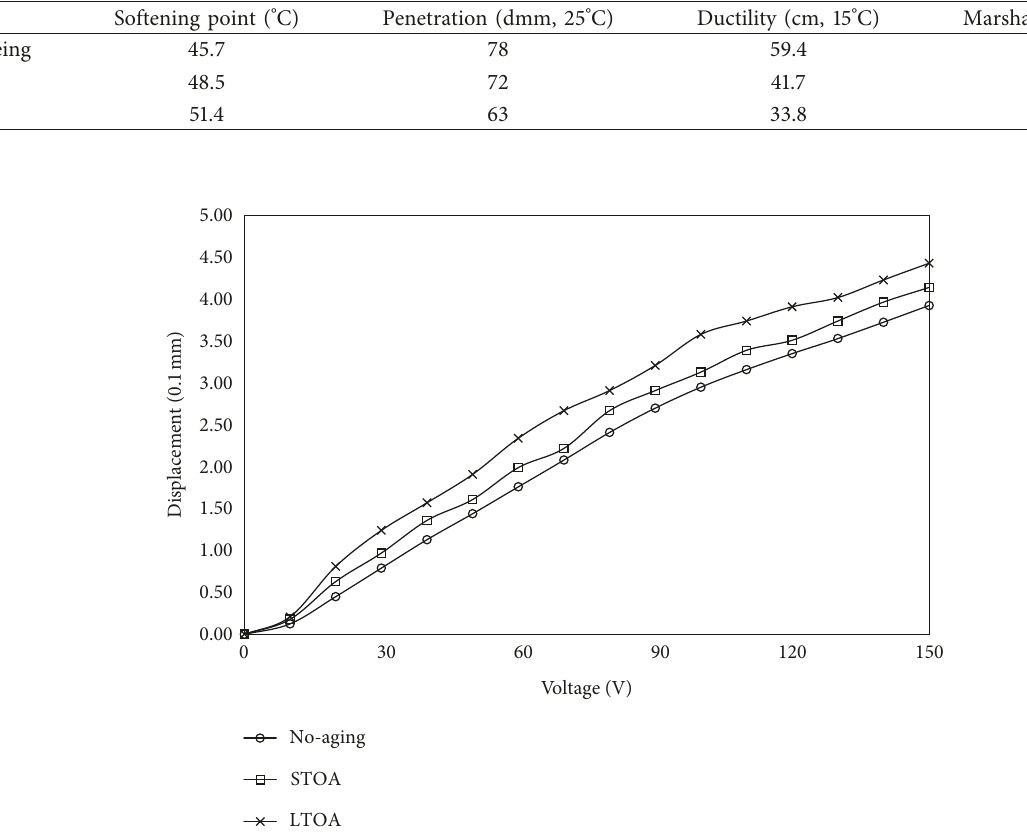
Figure 7: Displacement-voltage curve of KNN element in asphalt concrete after ageing.